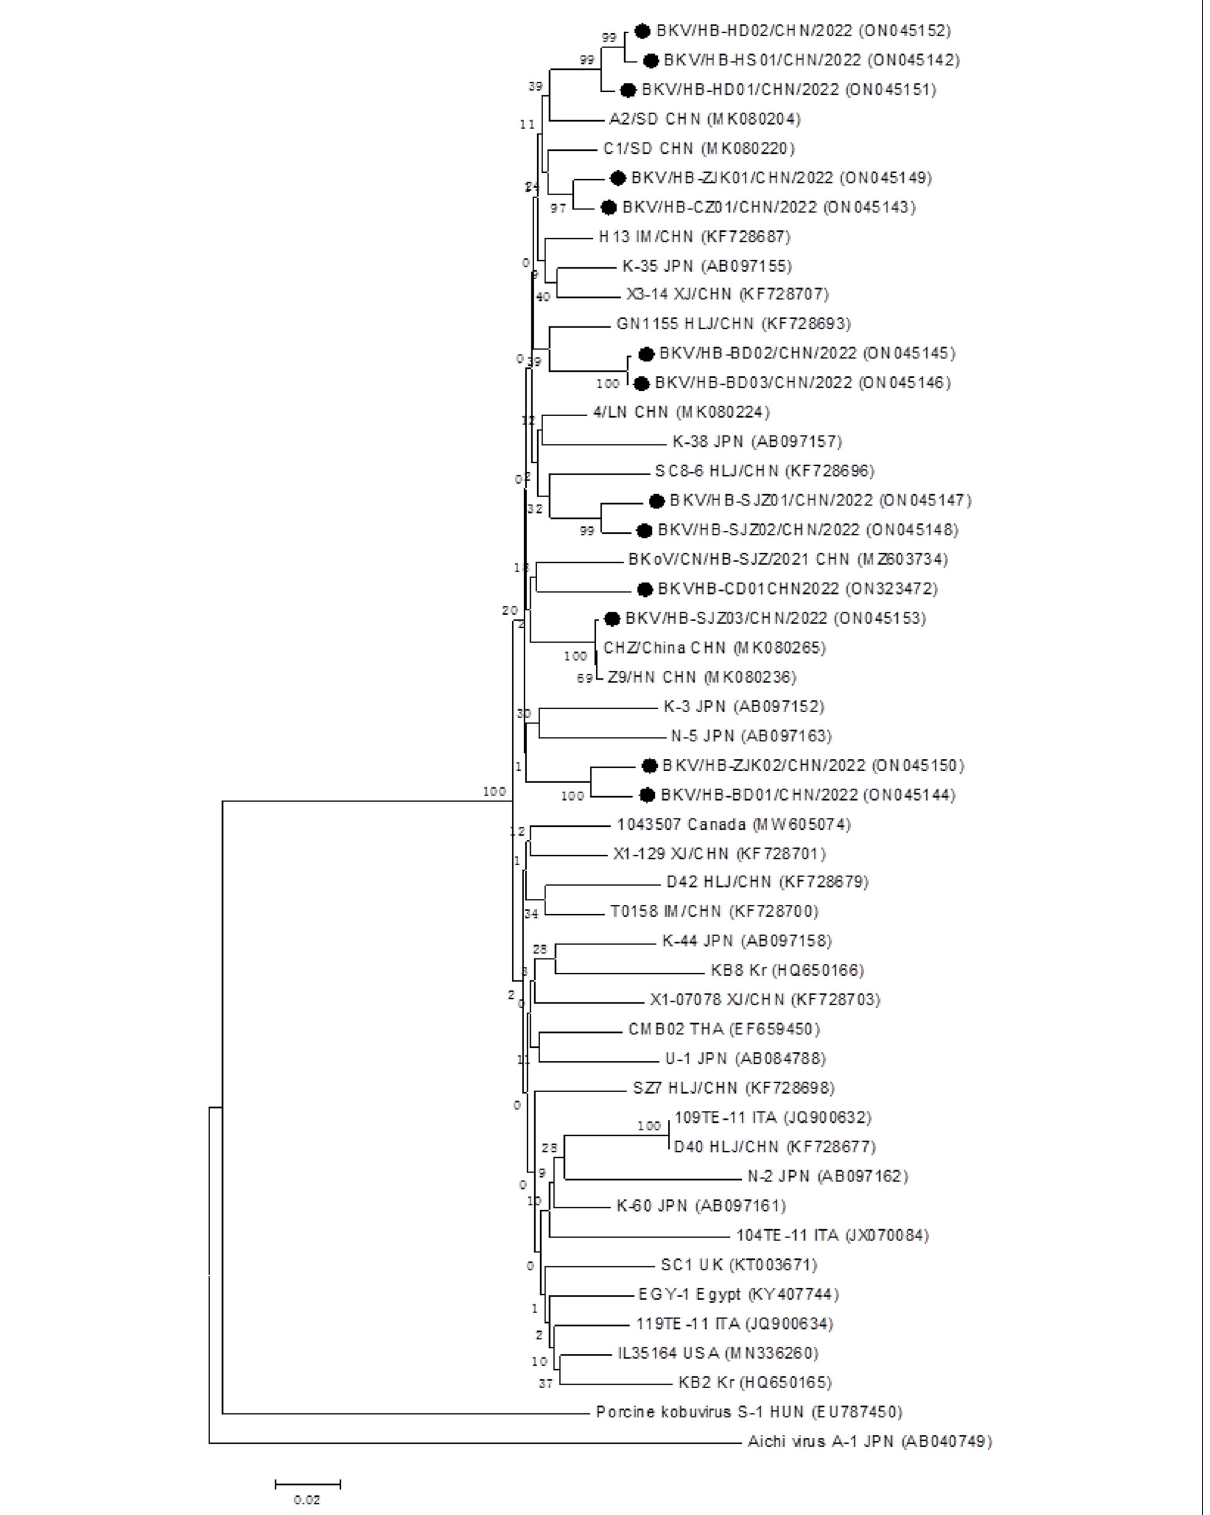
FIGURE3 Phylogenetic analysis of the BKV strains based on the nucleotide sequences of their 552 bp partial 3D genes. The phylogenetic tree was constructed by the neighbor-joining clustering method with 1,000 bootstrap replicates, using MEGA version 6.05 software. Black circles referred to Hebei strains identified in this study. All accession numbers used in this study had been labeled in the